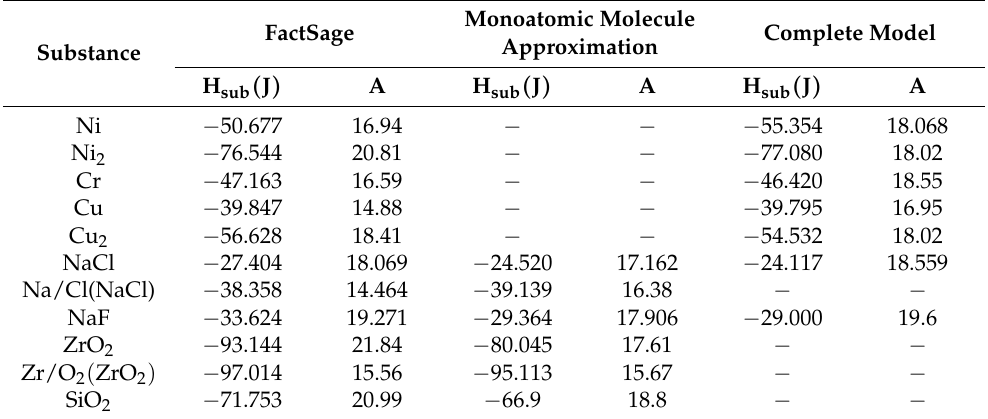
Table 2. Comparison of the prediction to the thermodynamic database